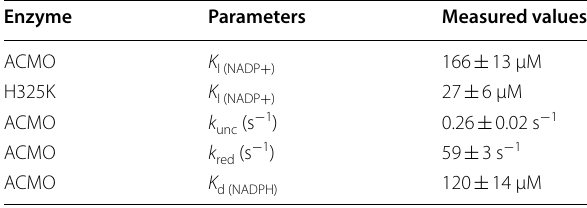
The inhibition constant for NADP + , K i (NADP was determined in the presence + ) of 200 μM butanone. The turnover rates for uncoupled NADPH oxidation ( k unc ) ( K d (NADPH) ) were determined by fitting Eq. 6 to the data shown in Fig. 4a. All reactions were performed at 25 °C in 50 mM HEPES–NaOH, pH